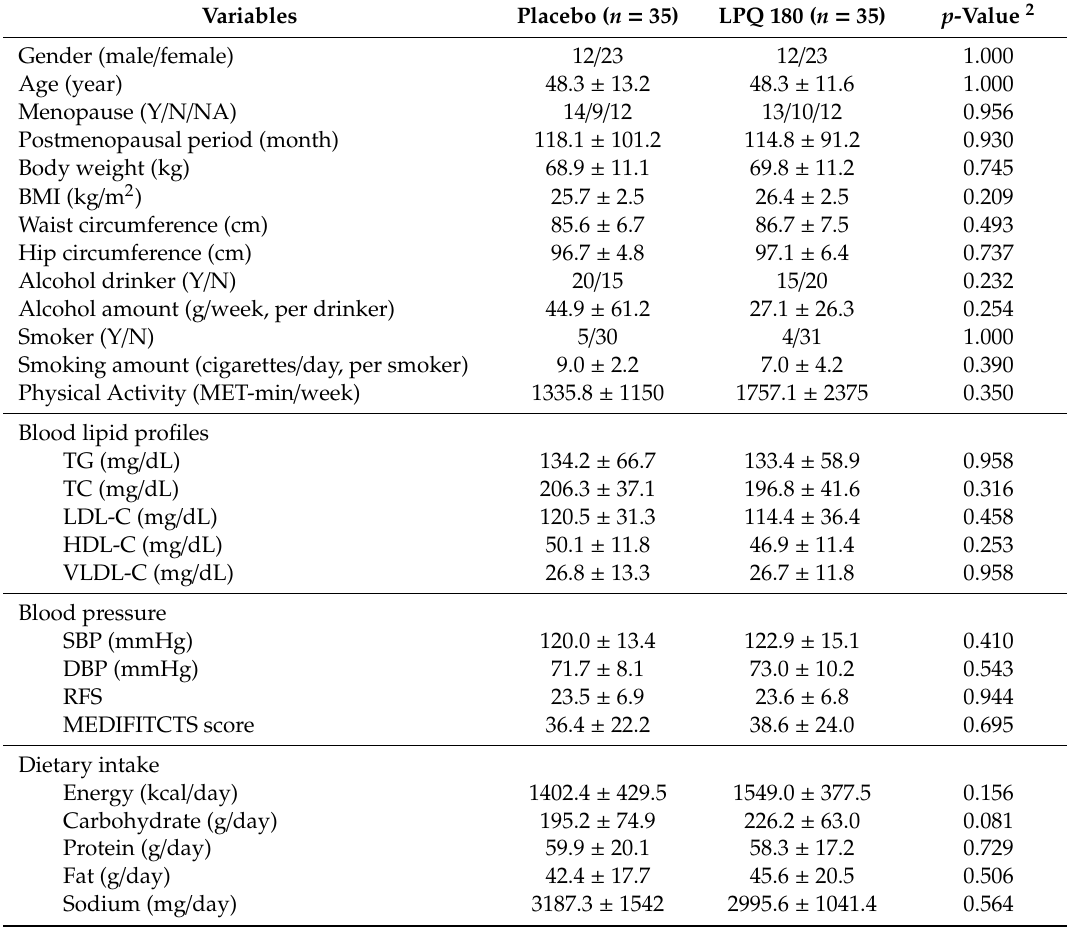
Table 1. Baseline characteristics of the subjects 1 .